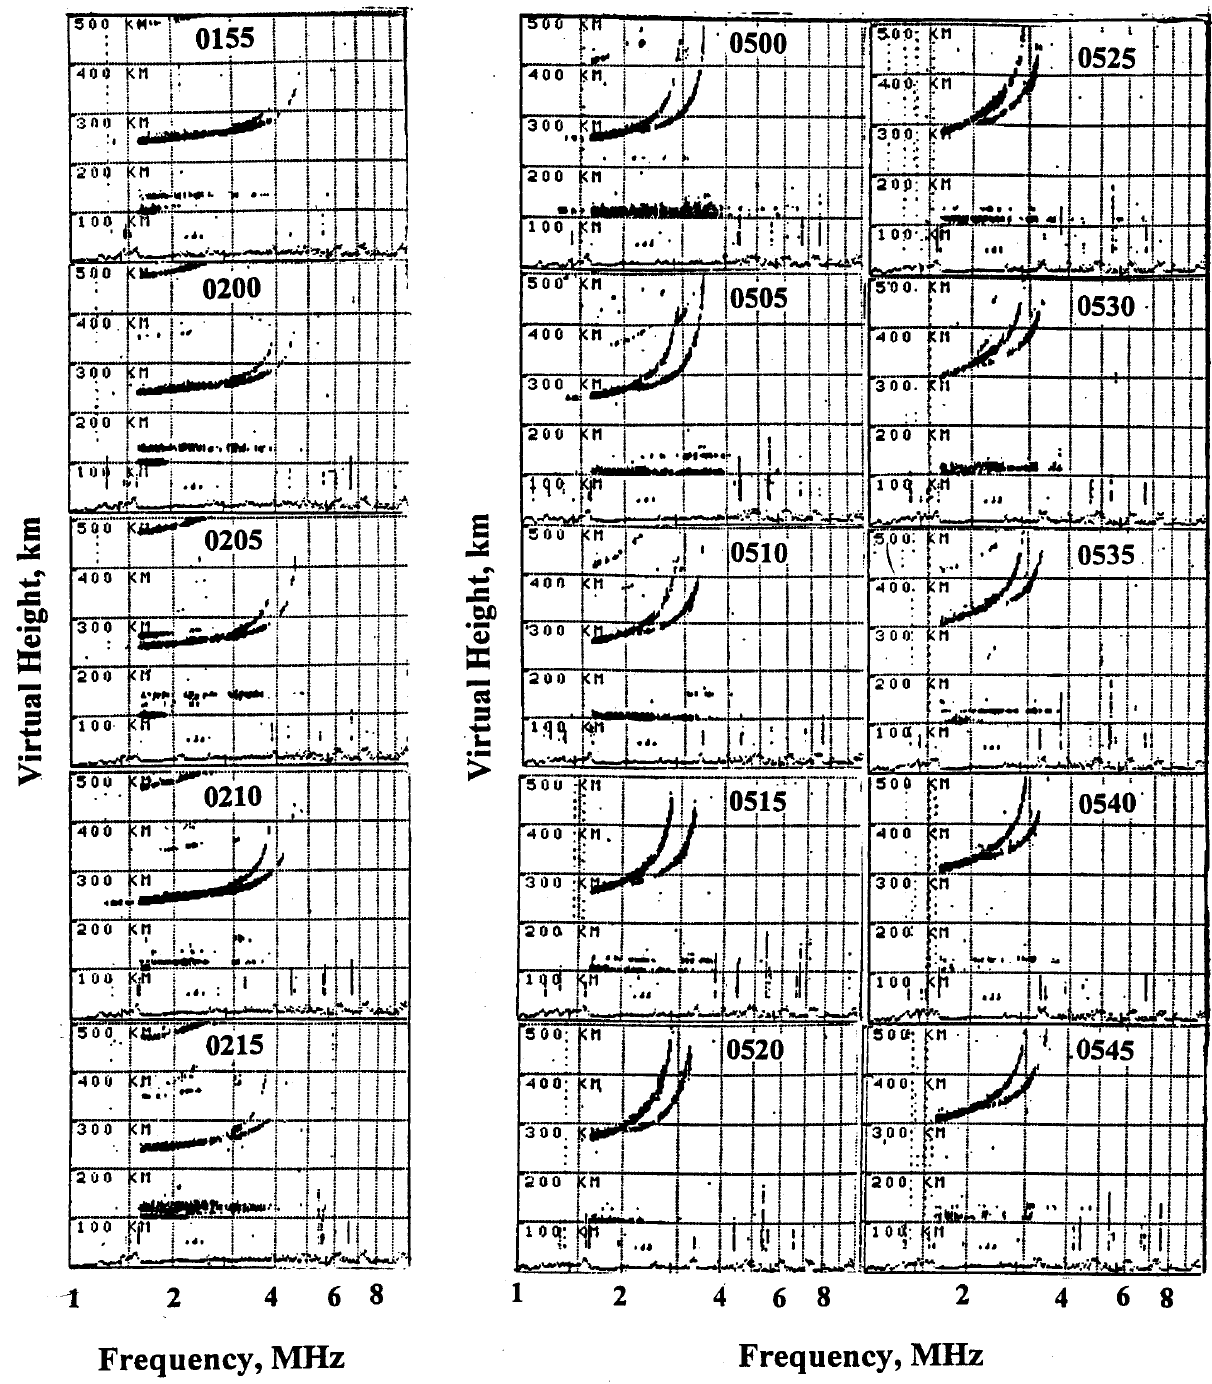
Fig. 7. Two sequences of ionograms at 5 minutes interval over Ahmedabad from 0155 to 0215h and from 0500 to 0545h of 17 November 1998 showing the development of sporadic-E associated with Leonid shower